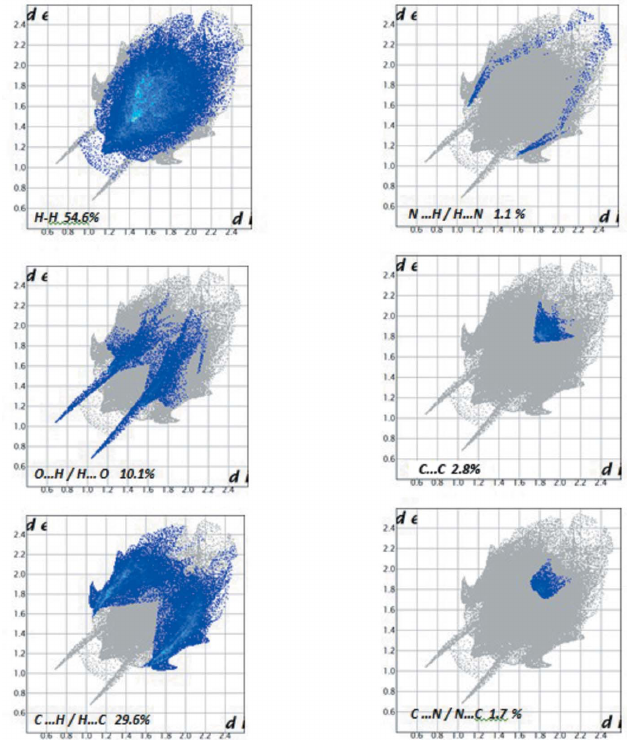
Figure 4 Two-dimensional fingerprint plots of the title compound delineated into H (cid:3)(cid:3)(cid:3) H, O (cid:3)(cid:3)(cid:3) H/H (cid:3)(cid:3)(cid:3) O, C (cid:3)(cid:3)(cid:3) H/H (cid:3)(cid:3)(cid:3) C, N (cid:3)(cid:3)(cid:3) H/H (cid:3)(cid:3)(cid:3) N, C (cid:3)(cid:3)(cid:3) C, C (cid:3)(cid:3)(cid:3) N/N (cid:3)(cid:3)(cid:3) C contacts.